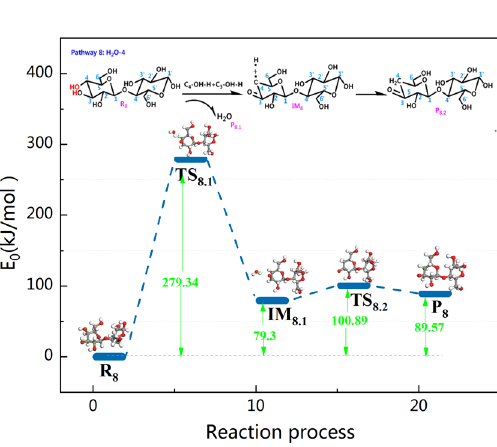
Figure 12. Reaction step and reaction energy barrier of pathway 7.